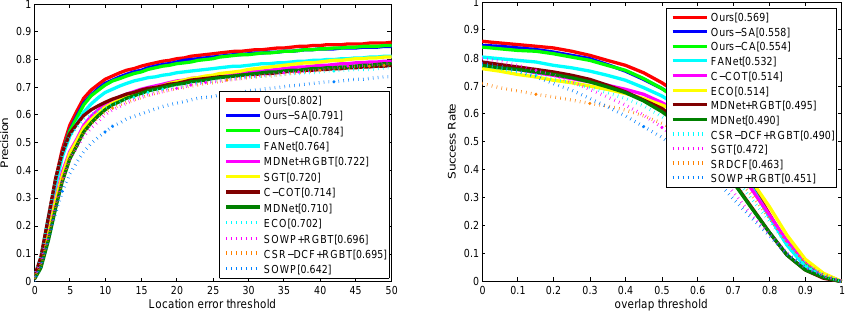
Figure 4. Performance comparisons on the RGBT234 dataset against state-of-the-art trackers. The attribute-based results on the RGBT234 dataset are shown in Table 1. The best, second and third results are in red, green and blue colors, respectively. It contains all 12 attributes annotated on the RGBT234 dataset: no occlusion (NO), partial occlusion (PO), heavy occlusion (HO), low illumination (LI), low resolution (LR), thermal crossover (TC), deformation (DEF), fast motion (FM), scale variation (SV), motion blur (MB), camera moving (CM) and background clutter (BC). As shown in Table 1, our framework achieves the best performance in all attributes. Compared with the baseline MDNet+RGBT, we obtain over 10%/8% PR/SR improvement in DEF (deformation) and BC (background clutter) challenges with the sharp target appearance changes. It demonstrates that the proposed spatial-aware mechanism can learn spatial awareness adaptively and enhance the target information for robust object tracking. In the challenging conditions, including HO (heavy occlusion) and TC (thermal crossover), the performance of the SCA-MMA framework is significantly higher than the baseline, which demonstrates the efficiency of the proposed channel-aware multi-modal adaptation